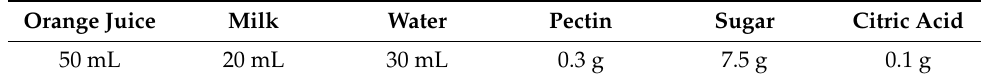
Table 1. Orange juice with milk ingredients per 100 mL.